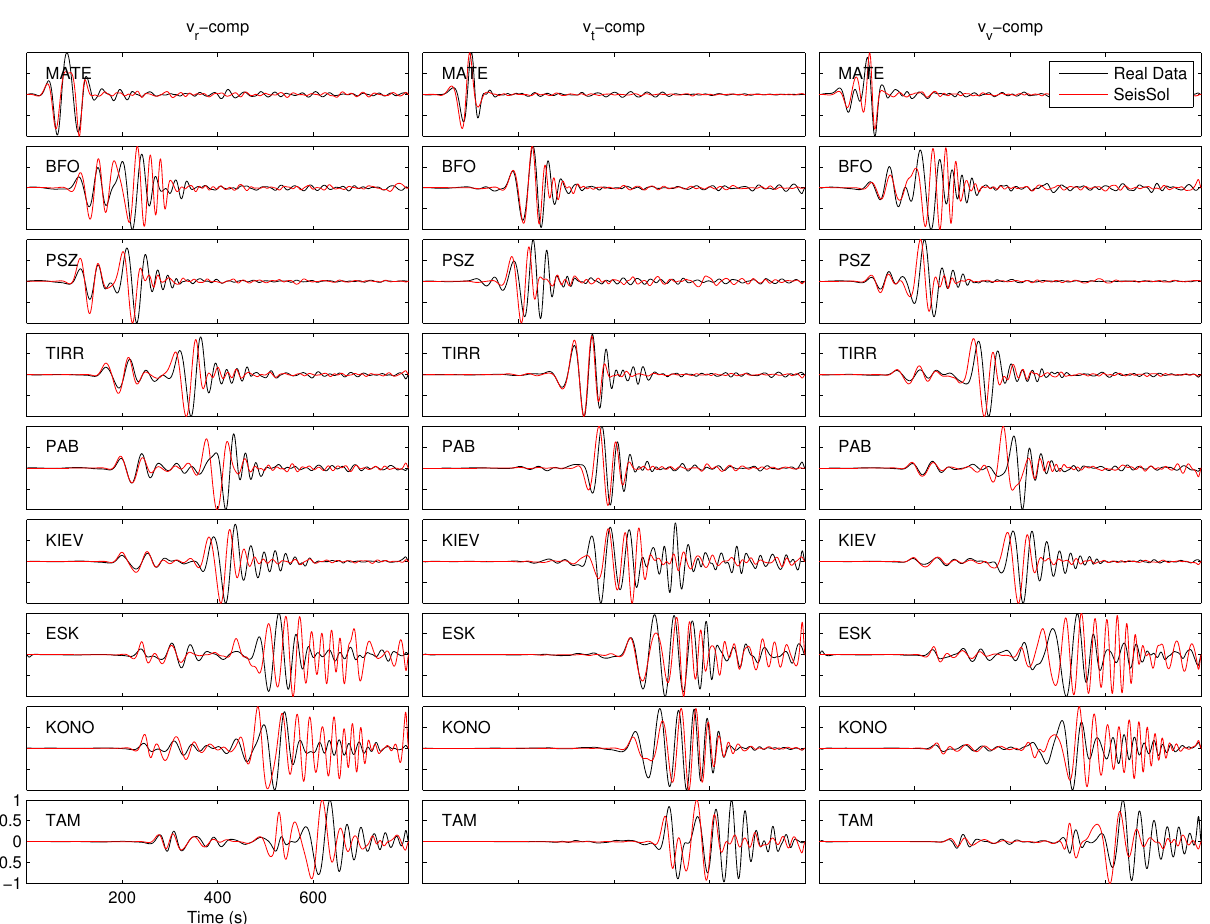
Fig. 8. Synthetic seismograms of the ADER-DG method obtained on the European model shown in Fig. 5 compared to real data of the 2009 L’Aquila earthquake at 9 different stations. The radial, transverse and vertical velocity components are shown for seismograms of 800s length, filtered to periods of T ≥